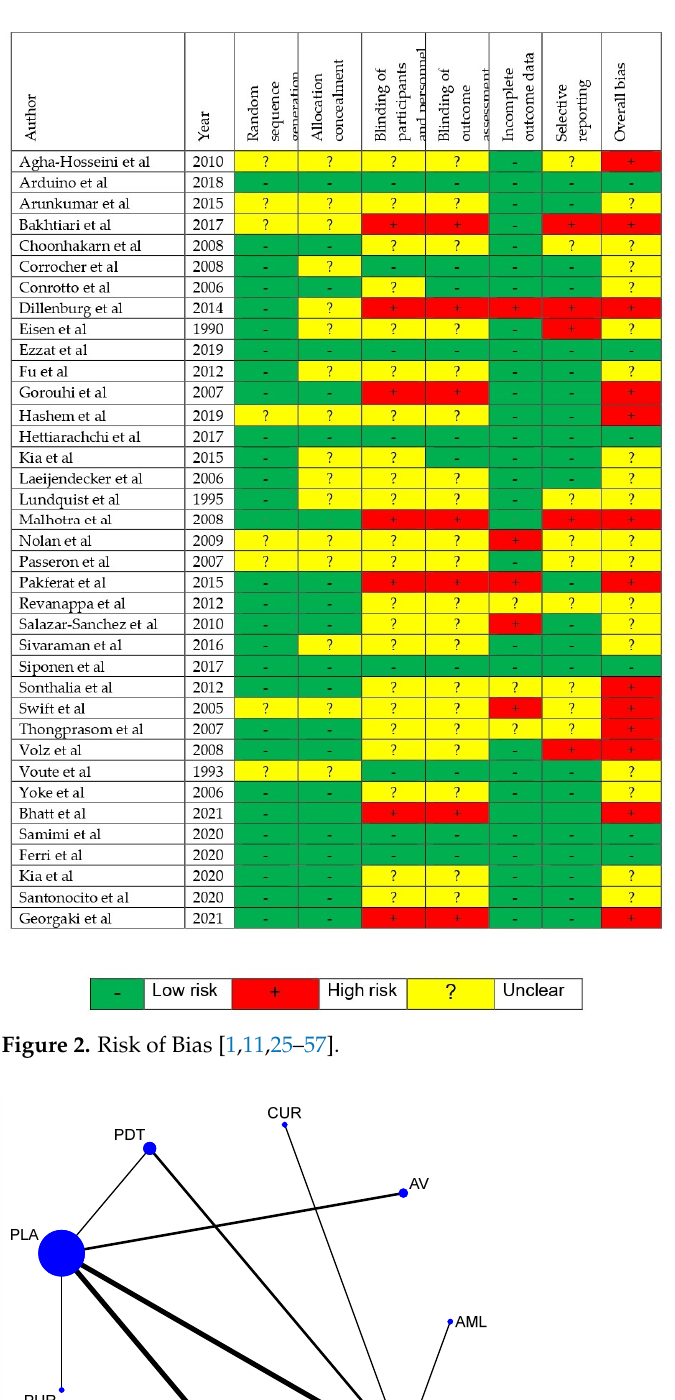
Figure 3. Network plot: Clinical Improvement of Oral Lichen Planus. Abbreviations: AML, amlexanox paste; AV, aloe vera; CUR, curcumin gel; PDT, photodynamic therapy; PLA, placebo; PUR, purslane; SysCORT, systemic corticosteroid; TopCALN, topical calcineurin; TopCALNcoSysCORT, topical calcineurin combined with systemic corticosteroid; TopCORT, topical corticosteroid.